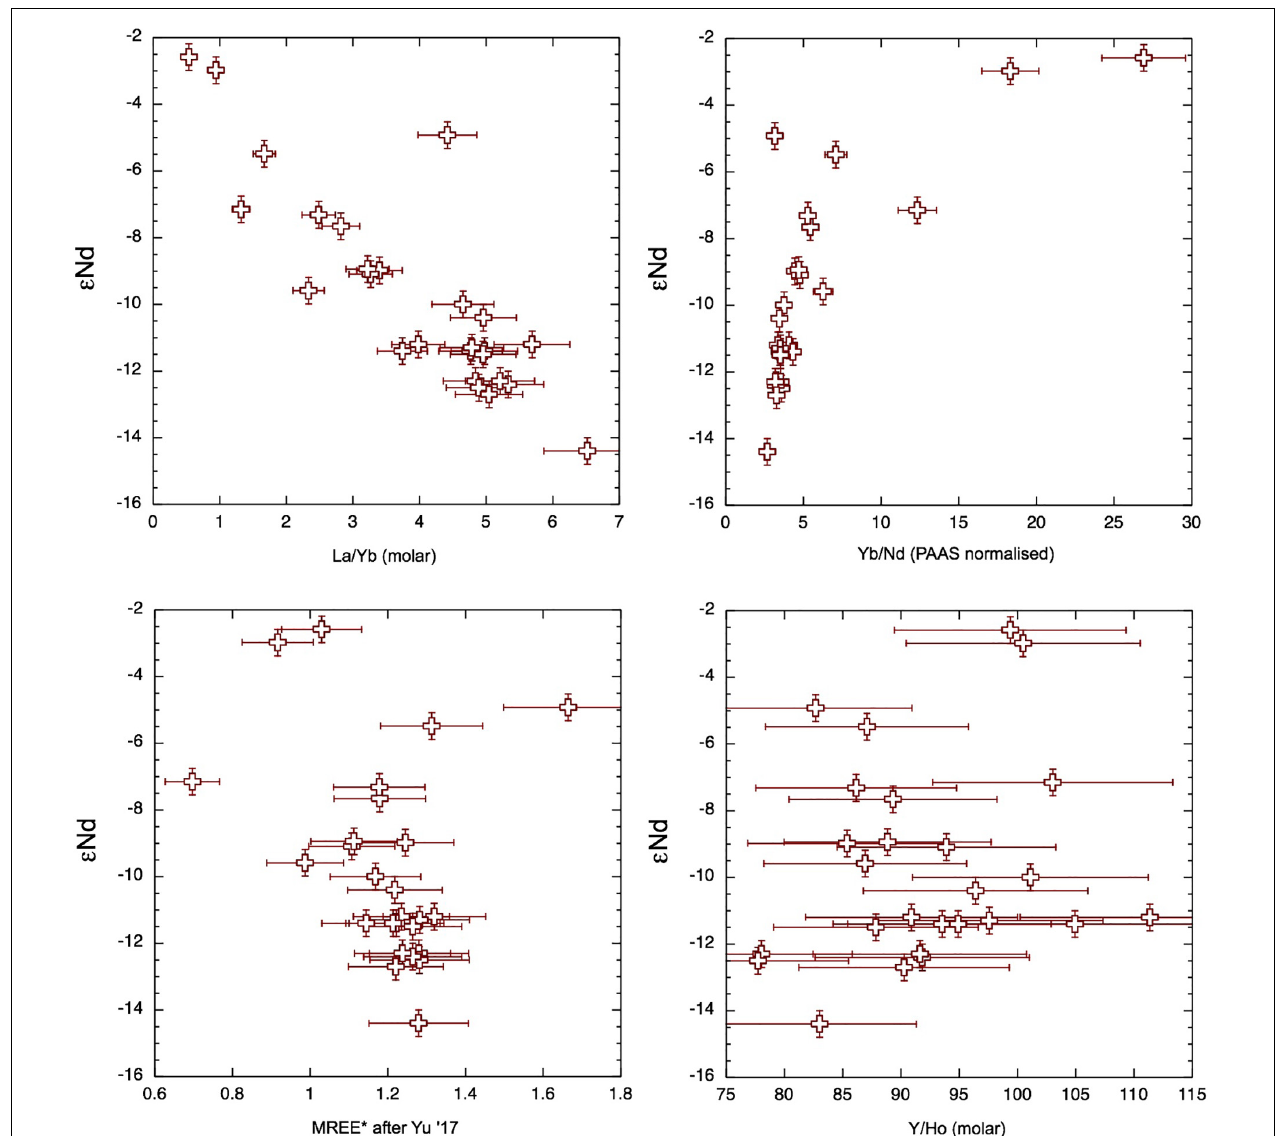
FIGURE 13 | Radiogenic Nd isotope composition vs. YREE indices for samples of this study together with values from the literature (Amakawa et al., 2000; Yu et al., 2017a,b) for samples from the upper 50-m water depth of the Bay of Bengal (BoB) and Andaman Sea (AnS) ( Figure 1